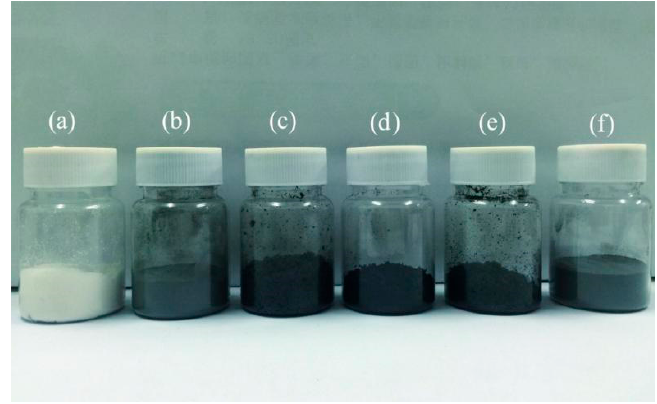
Figure 4. Optical images of various dry microcapsule powders: ( a ) M-0, ( b ) M-3, ( c ) M-4, ( d ) M-5, ( e ) M-6, and ( f ) M-7.